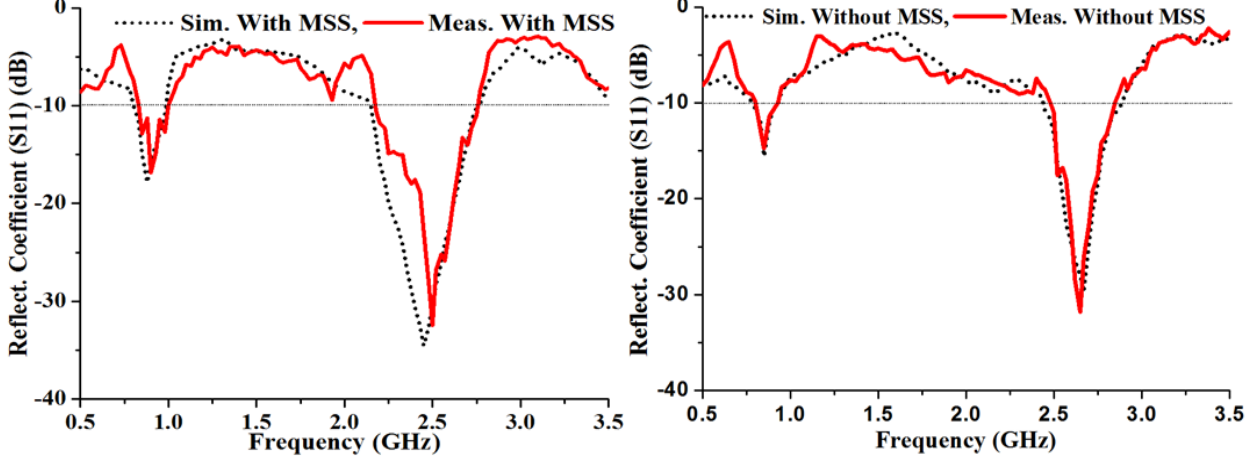
Figure 9. Simulated and measured reflection coefficient of the proposed antenna.